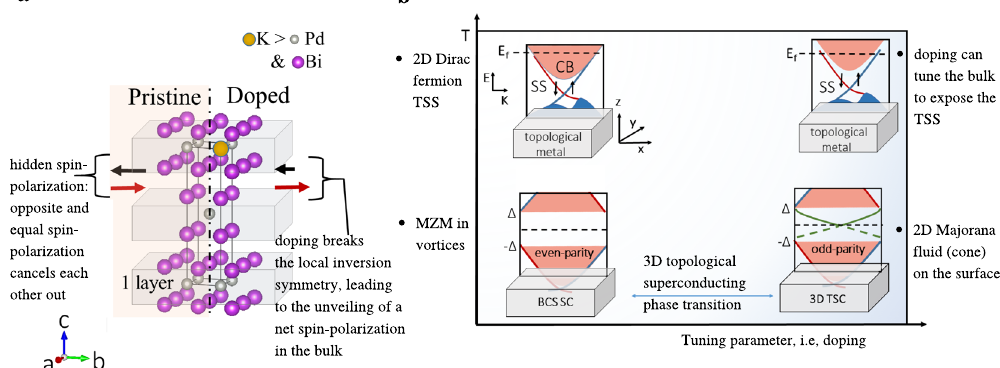
Figure 5. 3D topological superconducting phase transition. ( a ) Centrosymmetric, layered materials can possess hidden spin-polarization in the bulk 46 ; ‘hidden’ because the net spin-polarization cancels each other out. Naturally, the surfaces are spin-polarized, as is the case for pristine β -PdBi 2 which possess trivial spin-polarized surface-states in addition to the topological surface-states. We proposed here that a net spin-polarization in the bulk can arise due to the doping effect which breaks the local inversion symmetry at random, intermittent sites. ( b ) Upper-left: topological metal: Fermi level E f is placed above (or below) the topological surface states (SS). Upper-right: Doping depletes the bulk bands, exposing the SS. Lower-left: even-parity superconductivity in the bulk of a topological metal gaps out the bulk states and the Dirac SS; the superconductivity induced